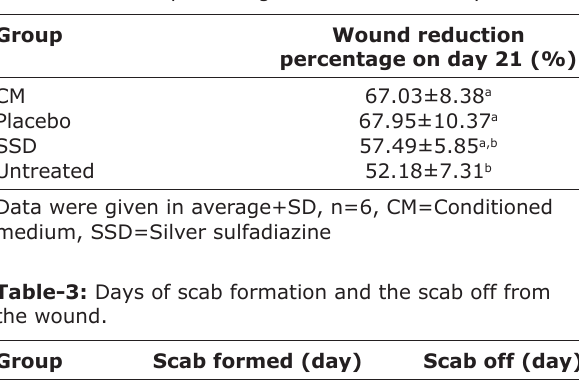
Table-2: Wound percentage reducement on day 21.